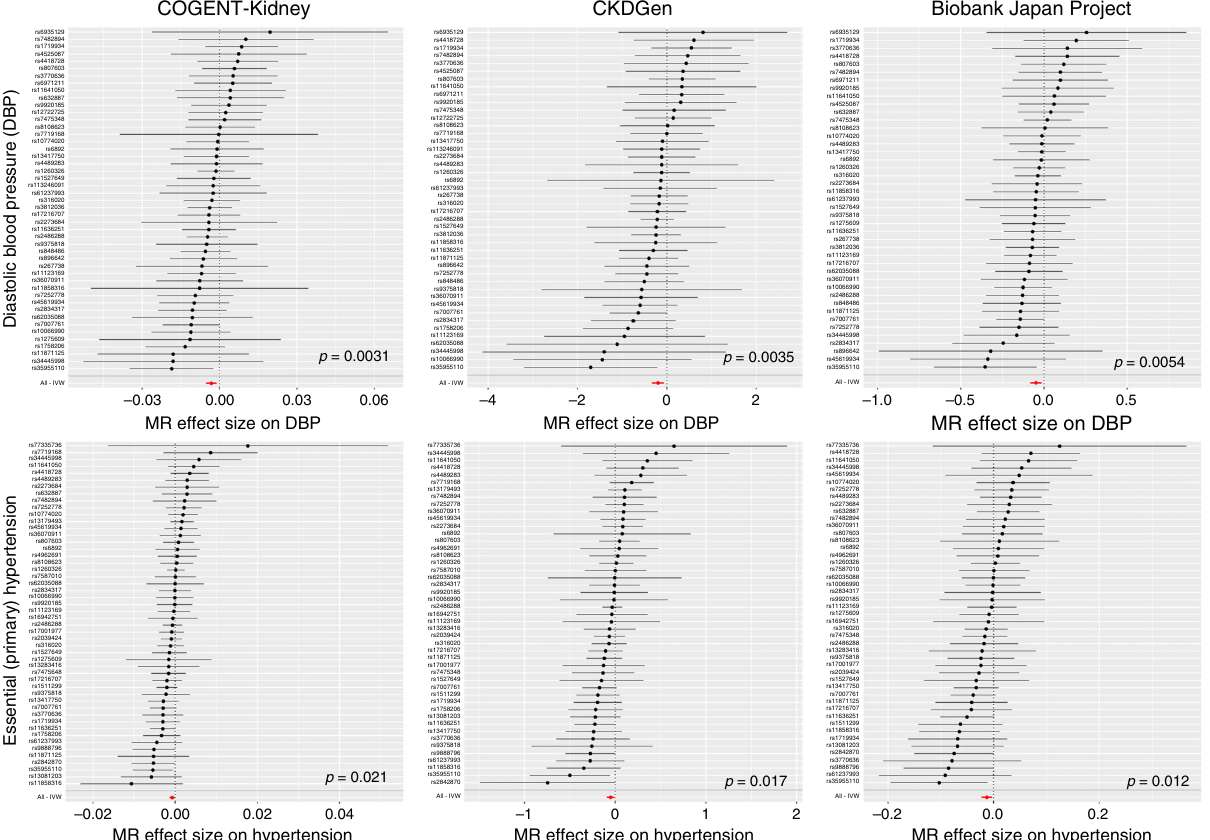
Fig. 4 Two-sample MR of eGFR on diastolic blood pressure and hypertension. Results are presented separately for each component of the trans-ethnic meta-analysis for diastolic blood pressure (top) and essential (primary) hypertension (bottom). Each point corresponds to a lead SNV (instrumental variable) across 94 kidney function loci, plotted according to the MR effect size of eGFR on outcome (Wald ratio). Bars correspond to the standard errors of the effect sizes. The red point and bar in each plot represents the MR effect size of eGFR on outcome across all SNVs under inverse variance weighted regression. The p -values are obtained under inverse variance weighted regression. Results for other methods are presented in Supplementary Table